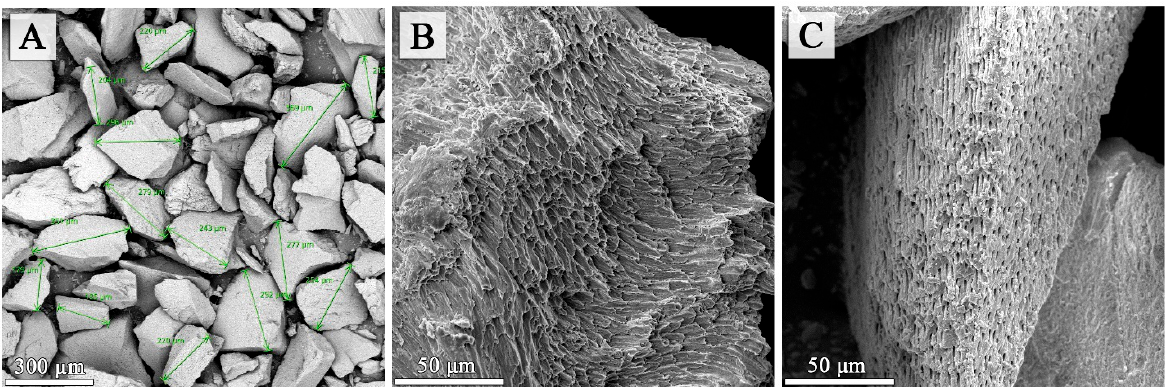
Figure 4. SEM images (magnification 200 and 1500×) obtained for powdered tooth samples. Images show: ( A )—fine powder of teeth (BSE mode), ( B , C ) show the structures at enamel and dentin pieces surfaces (SE mode).